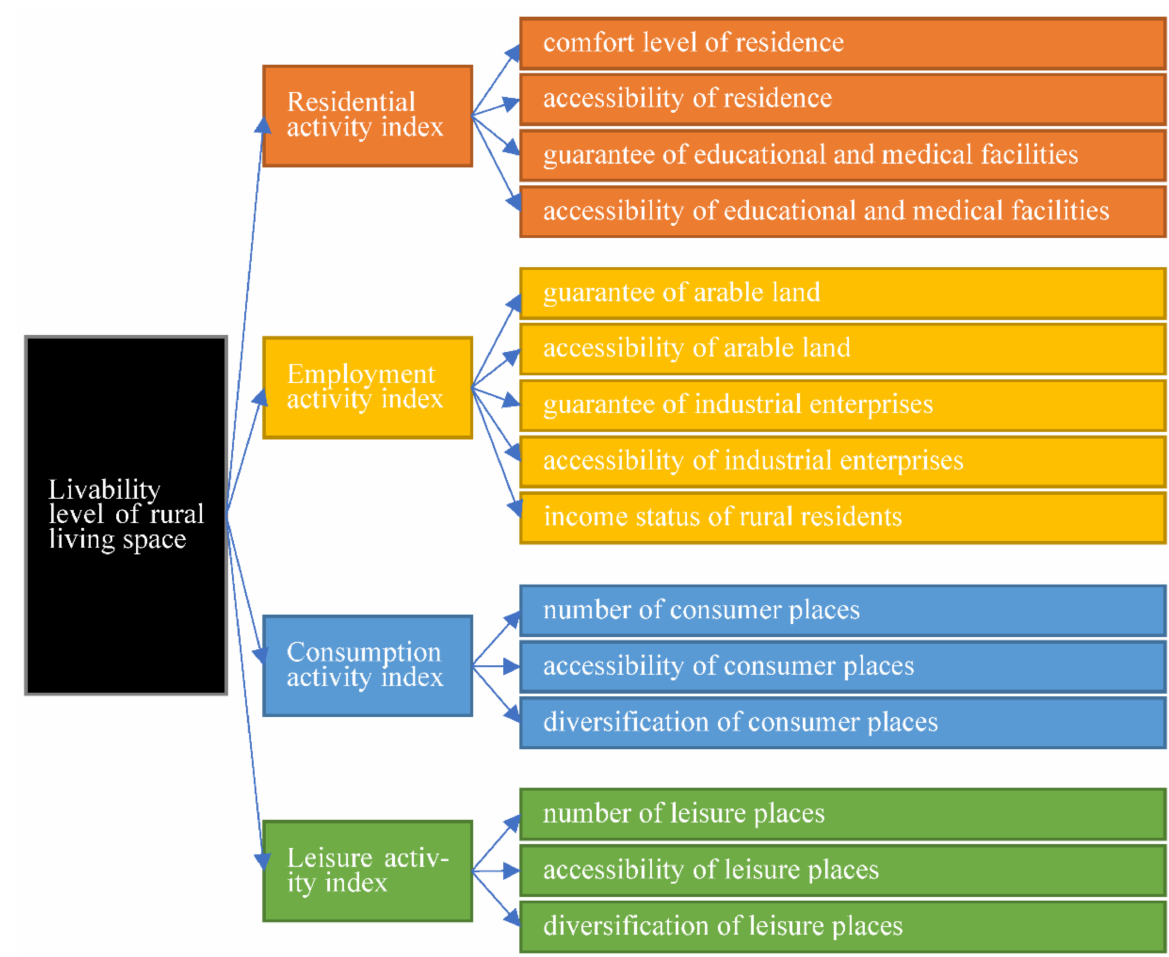
Figure 2. Analysis framework of the livability of living space in rural